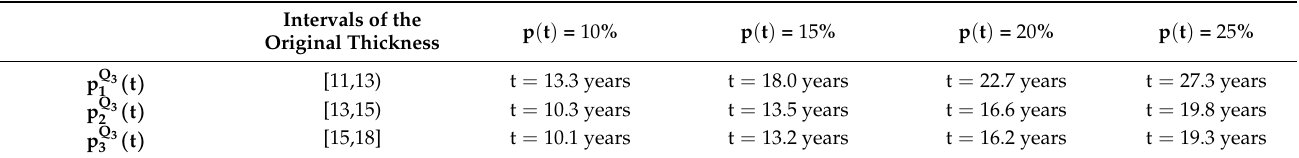
Table 5. The time when the critical values of wear percentage are